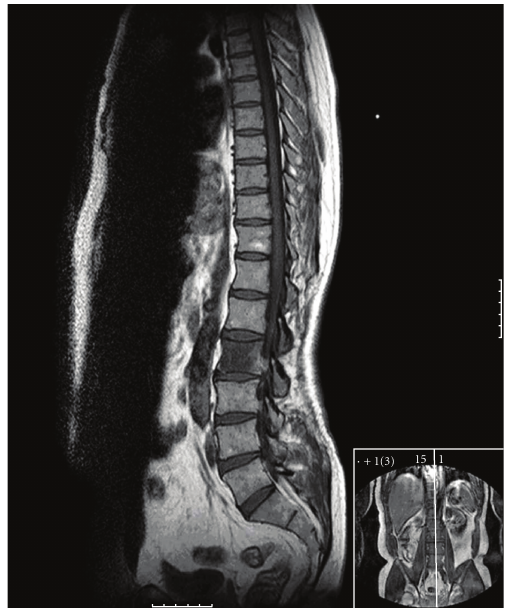
Figure 1: The MRI scan shows homogeneous isointense signal relative to skeletal muscle on T1-weighted images throughout L2 vertebra. The cortex is